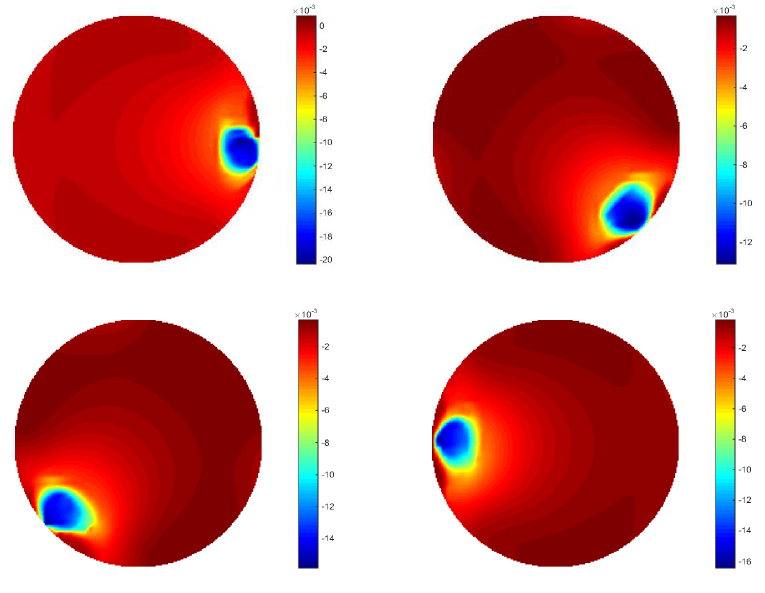
Figure 3. Reconstructed images of inclusion in the simulation test using Temporal TV: The movement path of the inclusion in the simulation test was a circle, where 8 images are selected to show how was the movement of the inclusion within the domain. Each of the sub-graph displaying the location of the inclusion at that time-step.